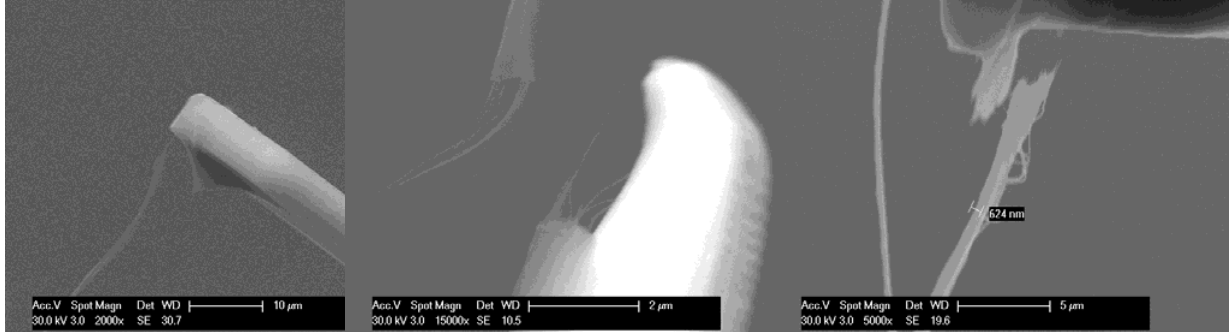
Figure 3. In strength tests, the breaking point is always near the SEM glue.